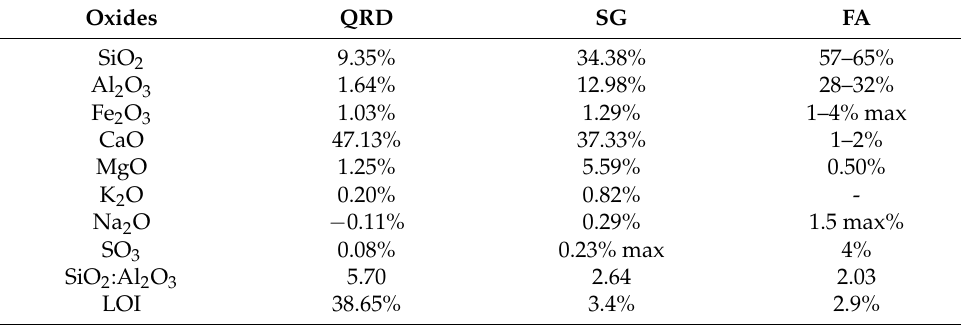
Table 2. The chemical composition of QRD, SG, and FA used in the present study.